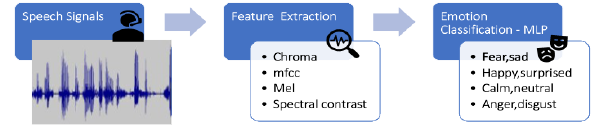
Fig. 1. Overview of project